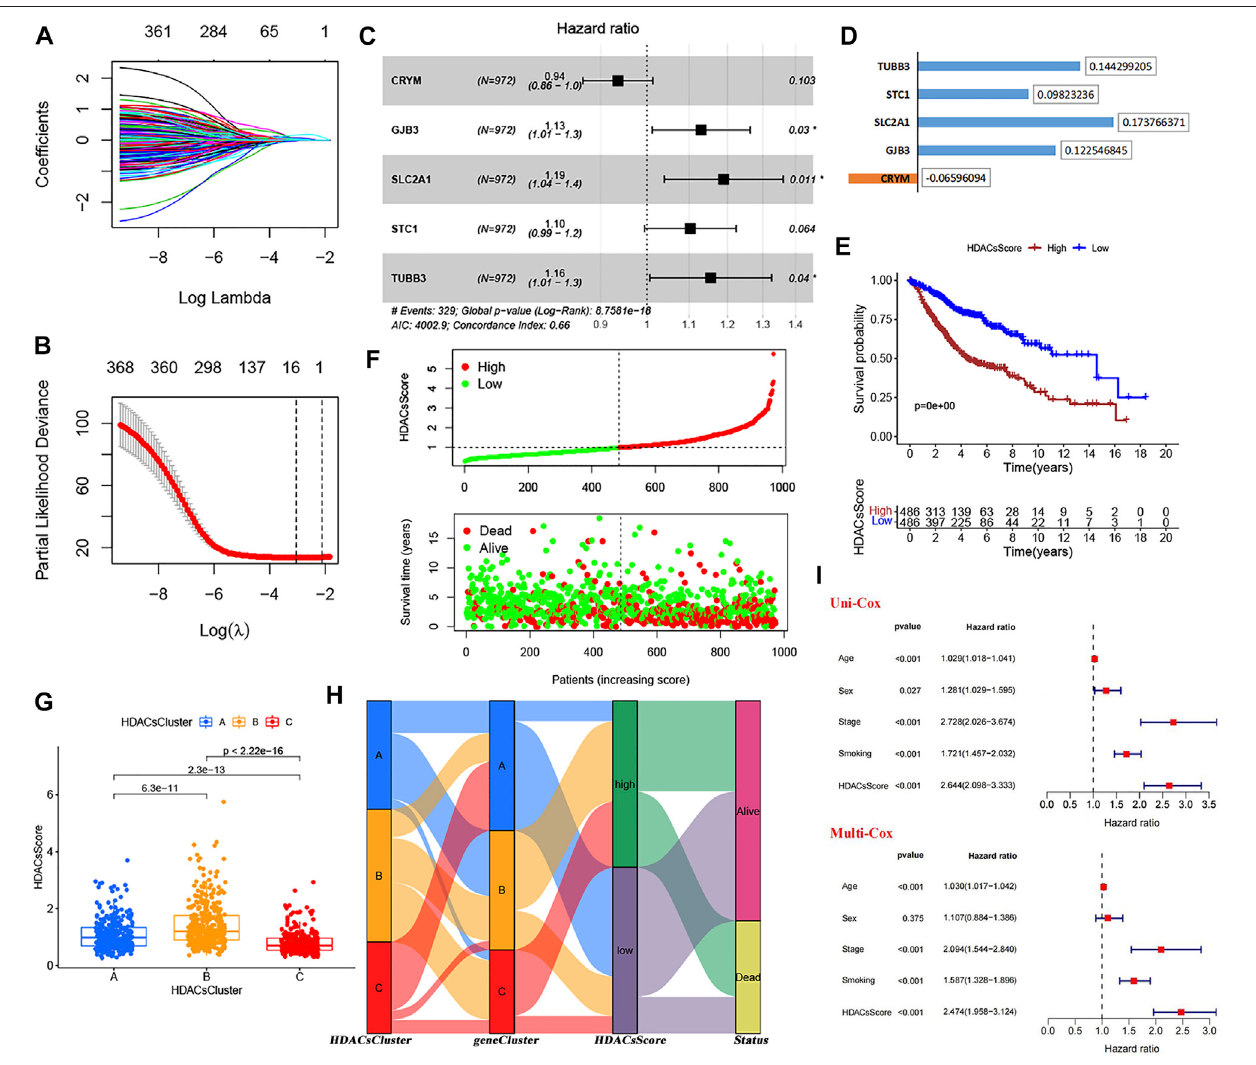
FIGURE 4 | Construction and validation of the HDAC scoring system. (A − B) LASSO regression analysis of 371 prognosis-related DEGs to avoid the model over fi tting. (C) Multivariate Cox analysis (stepwise regression) of the fi ltered genes in the meta-GEO cohort. (D) Correlation coef fi cient of the model genes. (E) Survival analyses for low- (486 cases) and high-(486 cases) HDACsScore groups using Kaplan − Meier curves. (F) HDACsScore and OS status distribution of the model in the meta-GEOcohort. (G) CorrelationsbetweenHDACsScore andHDAC-mediated molecular subtypes(HDACsCluster). (H) Alluvialdiagramshowingthechangesof HDACsClusters, geneCluster, HDACsScore, and OS status. (I) Univariate and multivariate Cox analysis of clinical parameters and HDACsScore.